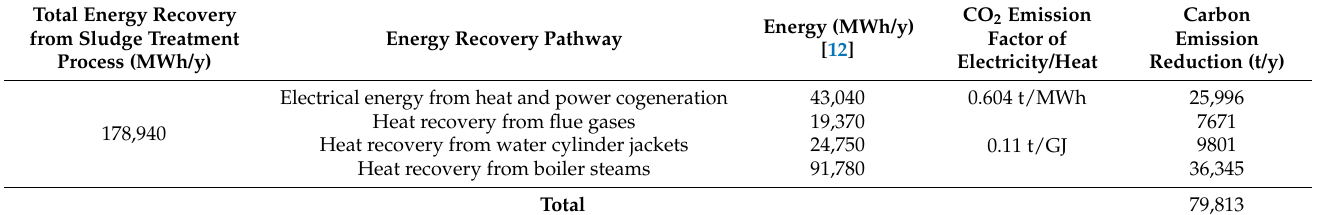
Table 7. Energy recovery from sludge treatment and its corresponding carbon emission